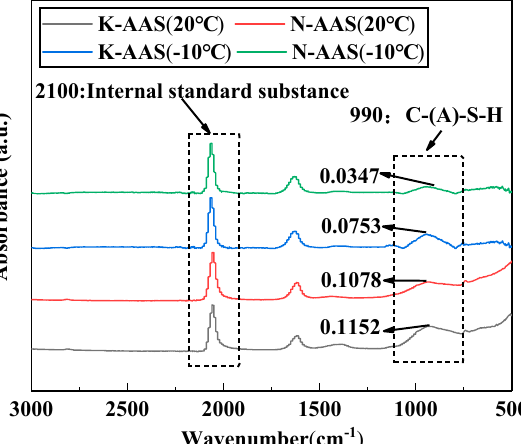
Figure 6. Effects of alkaline activator on the ART-FTIR spectra of samples at temperature of 20 ◦ C and − 10 ◦